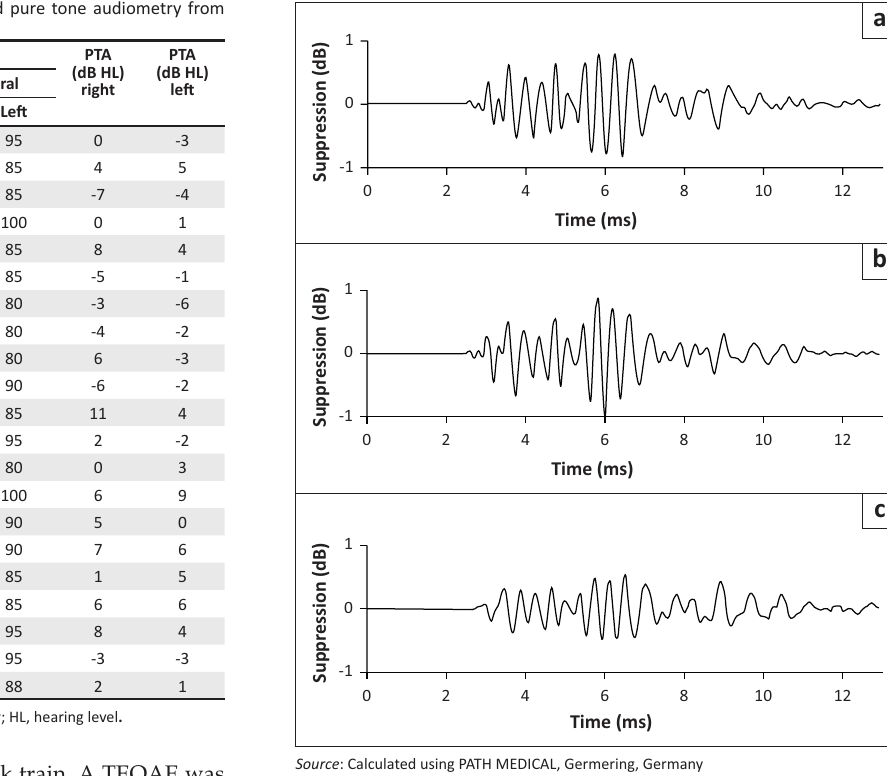
FIGURE 2: Graphical representation of the suppression calculation. (a) Unsuppressed, (b) suppressed and (c) difference.